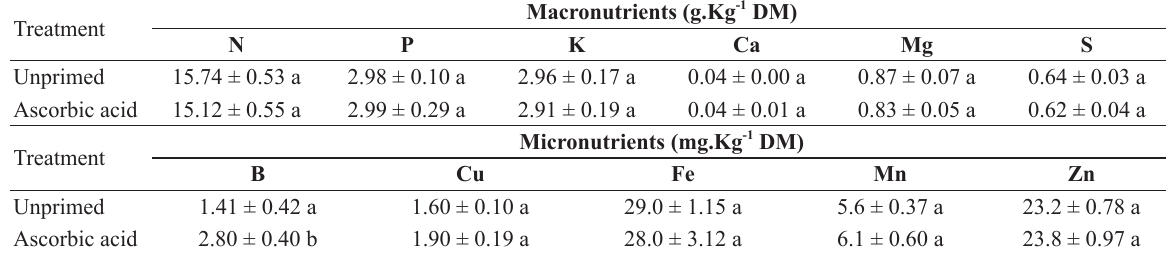
Mineral nutrients in the DA variety maize kernels.